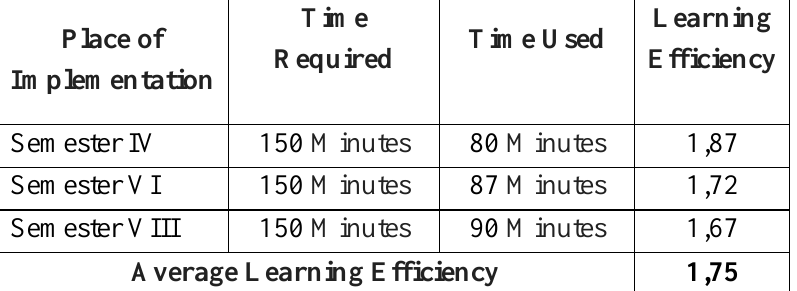
Table 1. Time spent on field